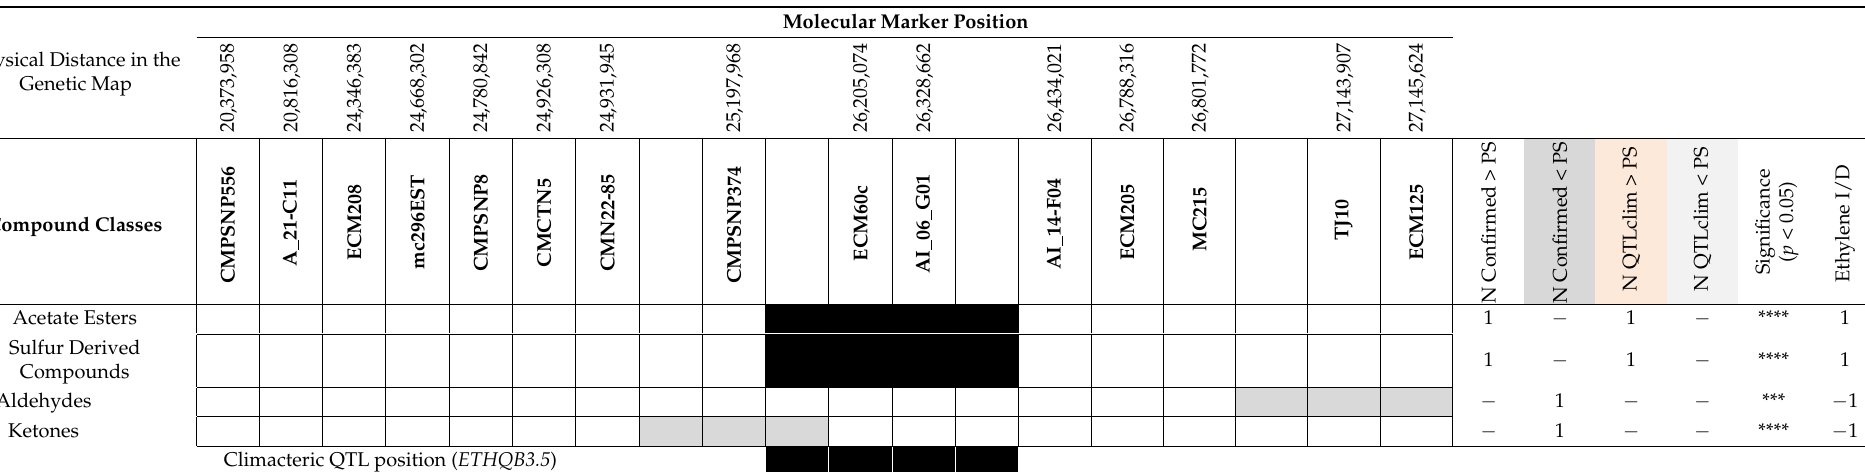
Table 3. QTL mapping of compound classes of aroma volatiles in melon chromosome 3 is depicted at the top according to [49] using the conventional nomenclature [61] for the chromosomes. For each aroma volatile, the estimated position of the QTL is indicated by a shadowed area and is colored dark when the SC [SC = ‘Shongwan Charmi’ (PI161375)] allele increased the trait or light color when it decreased the trait. Dark colors indicate values above PS, while light colors indicate values below PS levels. ETHQB3.5 is the region containing the QTL of the climacteric. I/D: Ethylene dependence (1) and independence ( −